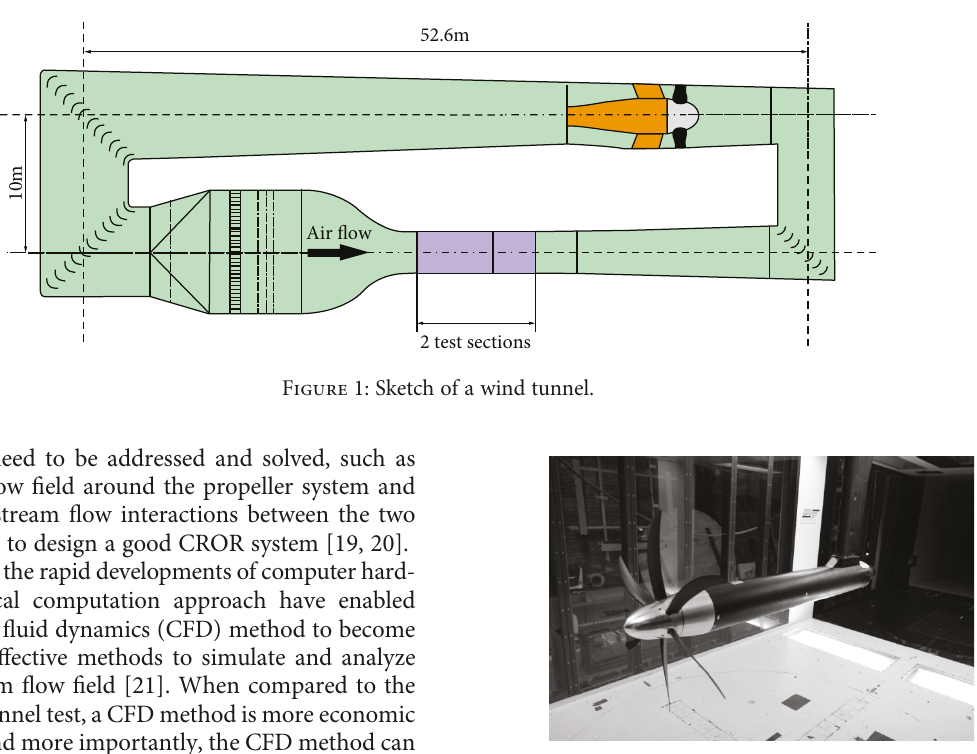
Figure 2: Isolated single-rotating propeller con fi guration in the DNW/LST wind